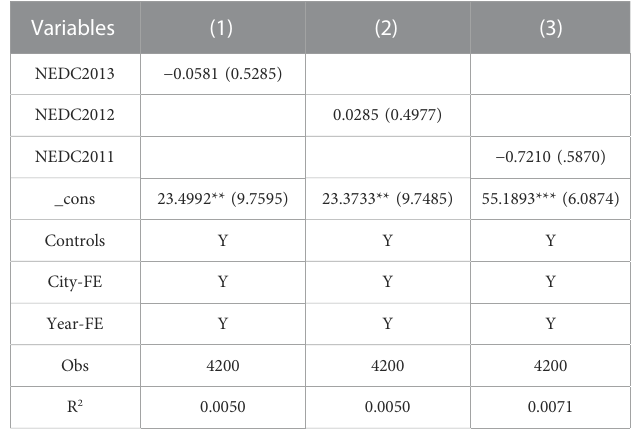
TABLE 3 Counterfactual test